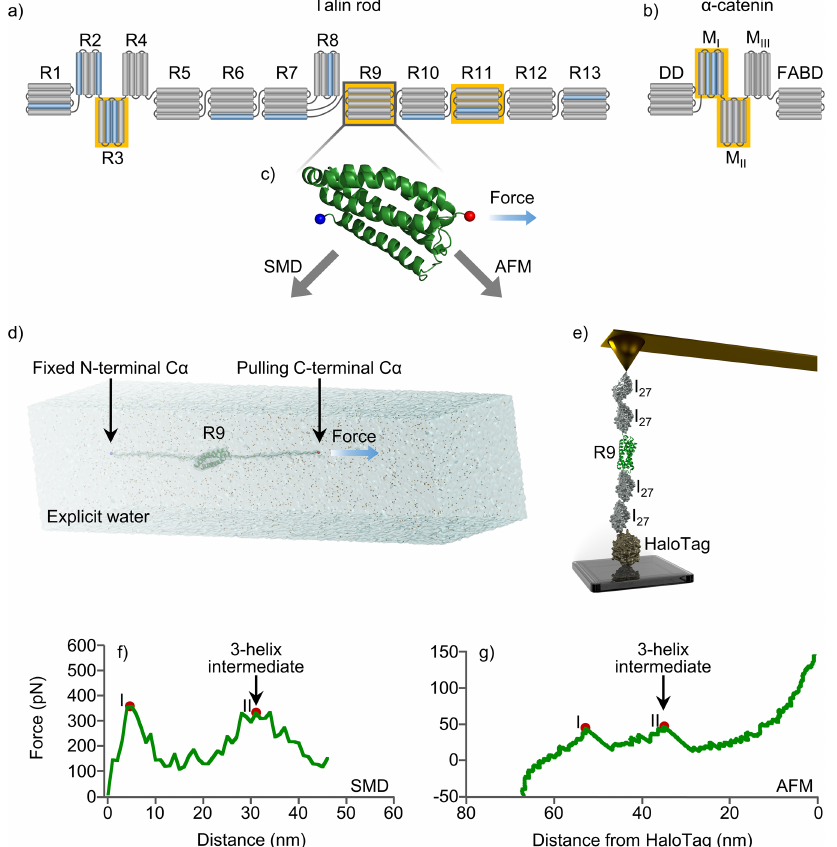
Fig 1. α -helix bundle mechanical stability. (a) Schematic representation of talin rod bundles and (b) α -catenin domains. Vinculin binding sites colored in blue. (c) Cartoon illustration of R9, where C α of N-terminal residue colored in blue and C α of C-terminal residue is red. (d) SMD water box and (e) smAFMsetup, that were used for end- to-end stretching of studied proteins. Unfolding force profiles of talin rod R9 in (f) SMD and (g) smAFM experiments, where after collapsing of 5-helix bundle (peak I) the stable 3-helix intermediate was found (peak II). α -helix bundles used in unfolding experiments highlighted with yellow.